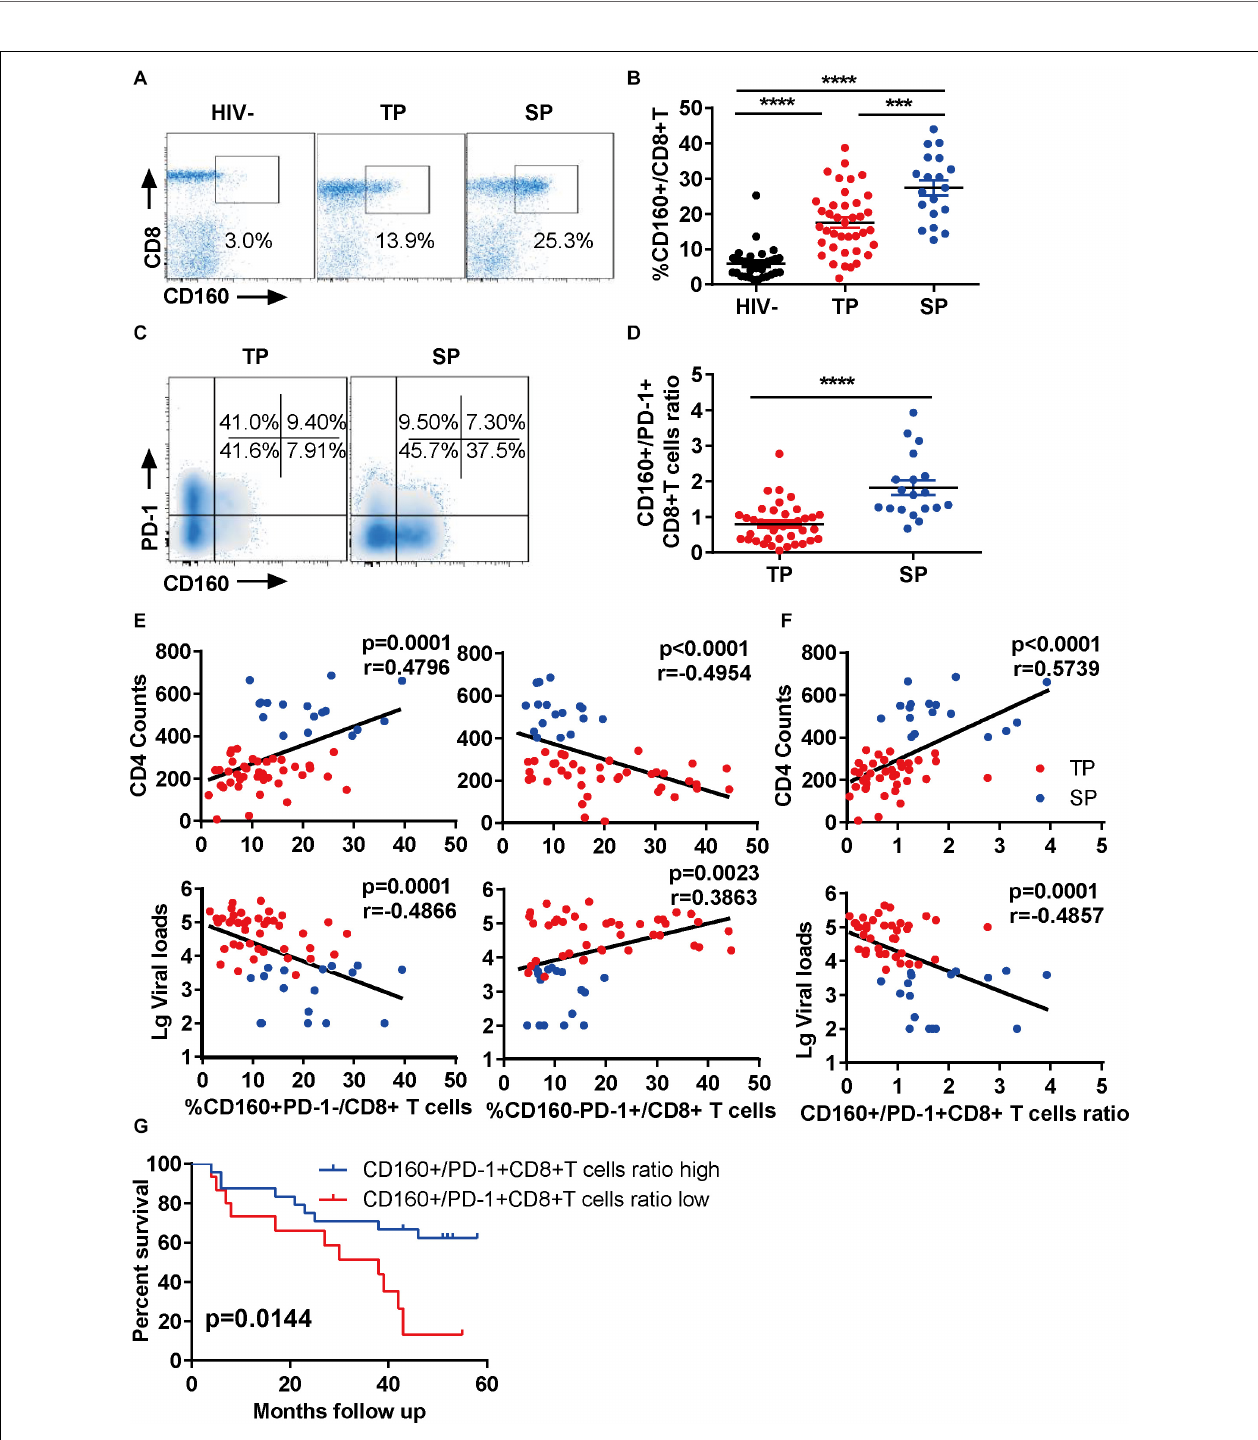
FIGURE 1 | CD160 correlates with slow progression during chronic HIV-1 infection. (A,B) Fresh human peripheral blood mononuclear cells were stained for CD160 expression on CD8+ T cells from three groups: slow progressors (SP), typical progressors (TP), and HIV-1 seronegative controls (HIV-). Representative flow cytometric plots are shown in (A) and summarized data in (B) . SP, n = 19; TP, n = 39; HIV-, n = 33. (C,D) Relative expression of CD160 and PD-1 on CD8+ T cells in SP versus TP. Representative flow cytometric plots are shown in (C) and summarized data in (D) . (E) Association between CD160+ PD-1- versus CD160-PD-1+ CD8+ T cell subpopulation and CD4 counts (upper panel) or plasma viral loads (lower panel) in HIV-1-infected subjects. (F) Association between relative CD160+/PD-1+ frequency and CD4 counts (upper panel) or plasma viral loads (lower panel) in HIV-1-infected subjects. SP, n = 17; TP, n = 41. (G) Prediction of disease progression using the ratio of CD160+ subpopulation to PD-1+ subpopulation with 5 years of follow-up. n = 56. The data in (B,D–G) are analyzed by Mann–Whitney U test, Spearman correlation, and log-rank test, respectively. The calculated p and r values are presented in the corresponding figures. The error bars in (B,D) represent SEM. *** P < 0.001; **** P < 0.0001.